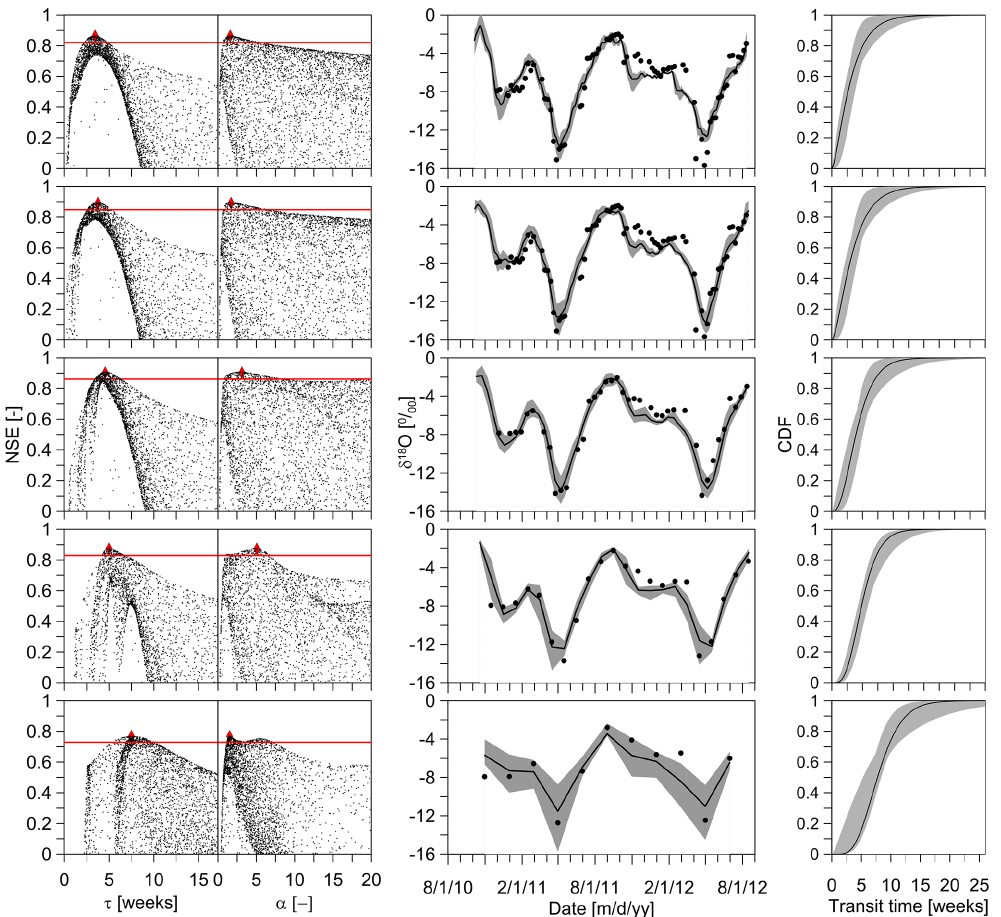
Figure 3. Predicted results for the soil water site C using the gamma lumped model (GM). Results are ranged from top to bottom according to the data resolution: daily (top panels), weekly, bi-weekly, monthly and bi-monthly (bottom panels). Left column panels show dotty plots for the model parameters ( τ and α ) according to NSE using Monte Carlo random simulations (GLUE approach). Red line shows the feasible range of behavioral solutions of model parameters as a 5% of the top best prediction (red diamond). Center column panels show the measured (black filled circles) and simulated δ 18 O (the black line and the shaded area represent the best possible solution and its range of variation according to the 5–95% of weighted quantiles derived from the confidence limits of behavioral solutions shown in the left column). Right column panels: soil water residence time distribution function corresponding to the best NSE; gray shaded area in each plot corresponds to the range of possible shapes of the distribution